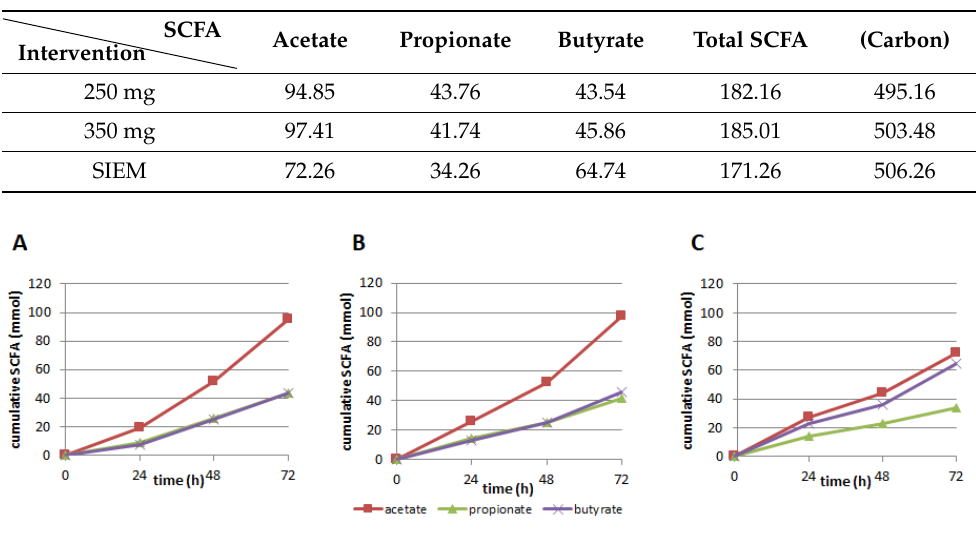
Figure 4. Cumulative production (mmol) of the short-chain fatty acids (SCFA) acetate, propionate, and butyrate at 24 h, 48 h, and 72 h after supplementation with ( A ) 250 mg; ( B ) 350 mg Citrus Fruit Extract, or ( C ) control (standard ileal efflux medium (SIEM)).